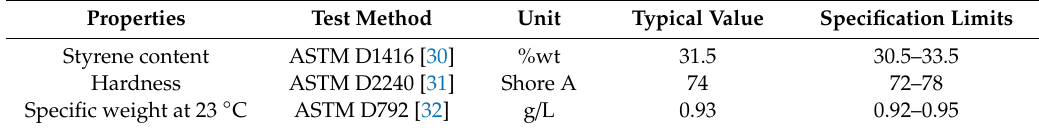
Table 3. Properties of styrene–butadiene–styrene.